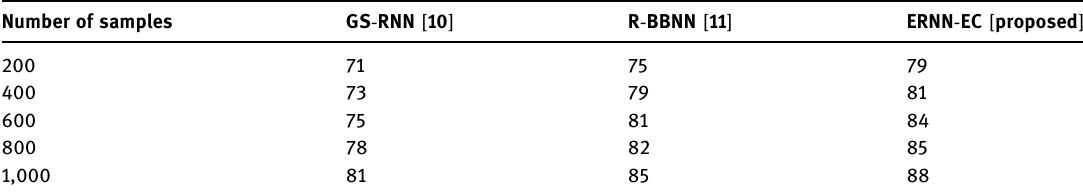
Table 6: Analysis of F 1 - score Number of samples